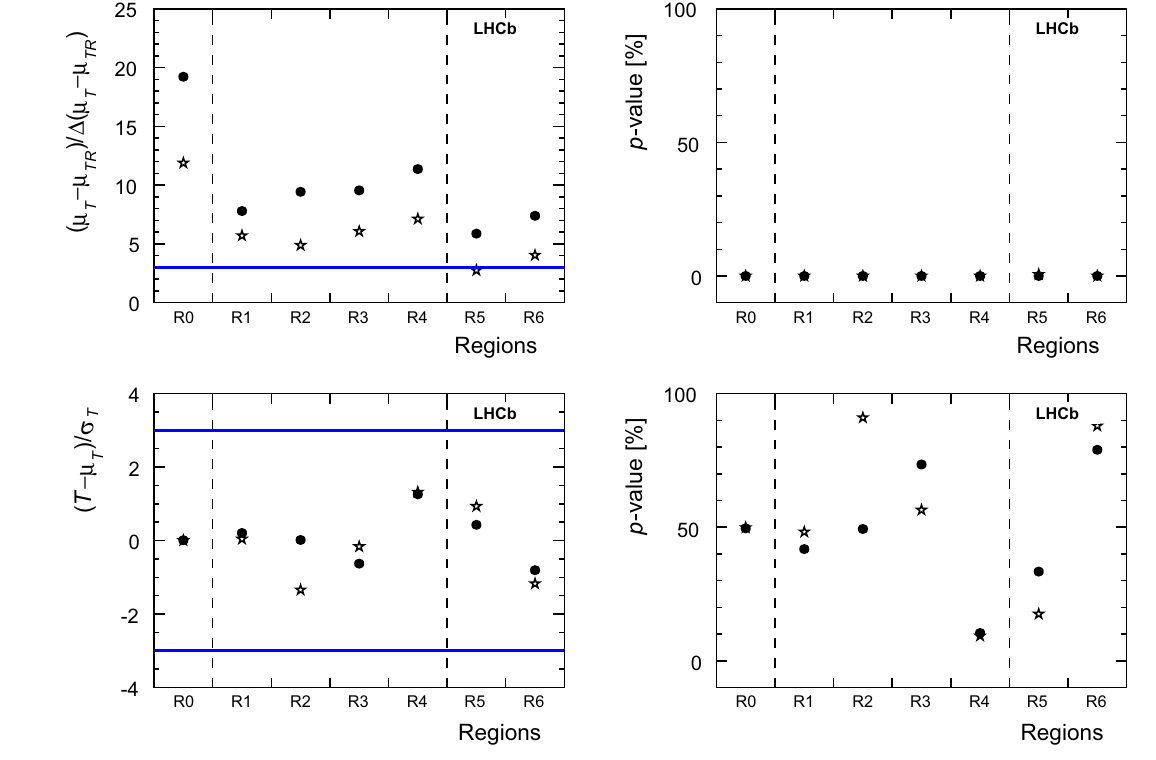
Fig. 6 (Top left) pulls, (μ T − μ T R )/Δ(μ T − μ T R ) , and (top right) the corresponding p -values, (bottom left) pull values of the test statistic T and (bottom right) the corresponding p -values in regions for con- trol Λ + c → pK − π + candidate decays obtained using the kNN method Fig. 7 Distributions of S i and CP corresponding one-dimensional distributions for Ξ + → pK − π + decays for the c combined data collected 2011 and 2012: (top row) 29 uniform bins and (bottom row) 111 uniform bins of the Dalitz